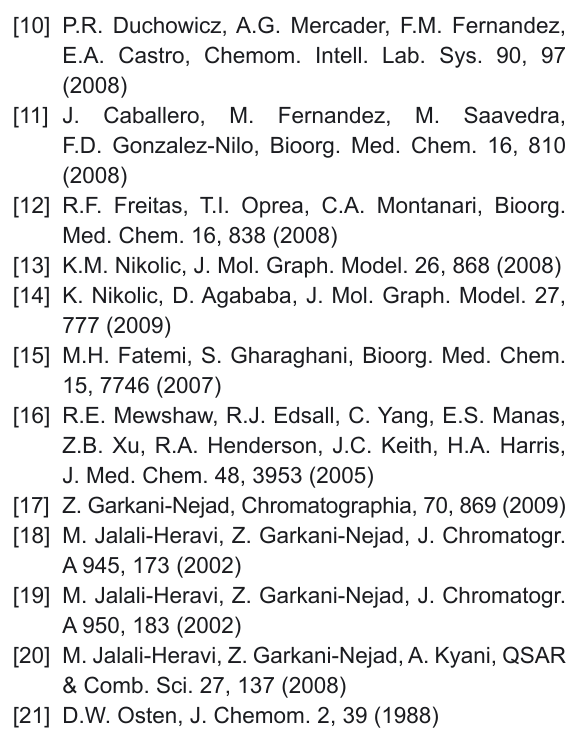
00.511.522.533.54 Figure 6. Experimental LogIC Figure 5. Experimental LogIC versus calculated LogIC plot 50 50 Fig. 5 shows the calculated logIC versus experimental 50 logIC for the training, test, and prediction sets. Fig. 6 50 shows the plot of residuals against the experimental values of logIC for the STANN model. The spread of 50 the residuals on both sides of zero indicates the lack of systematic error in the development of the STANNs.